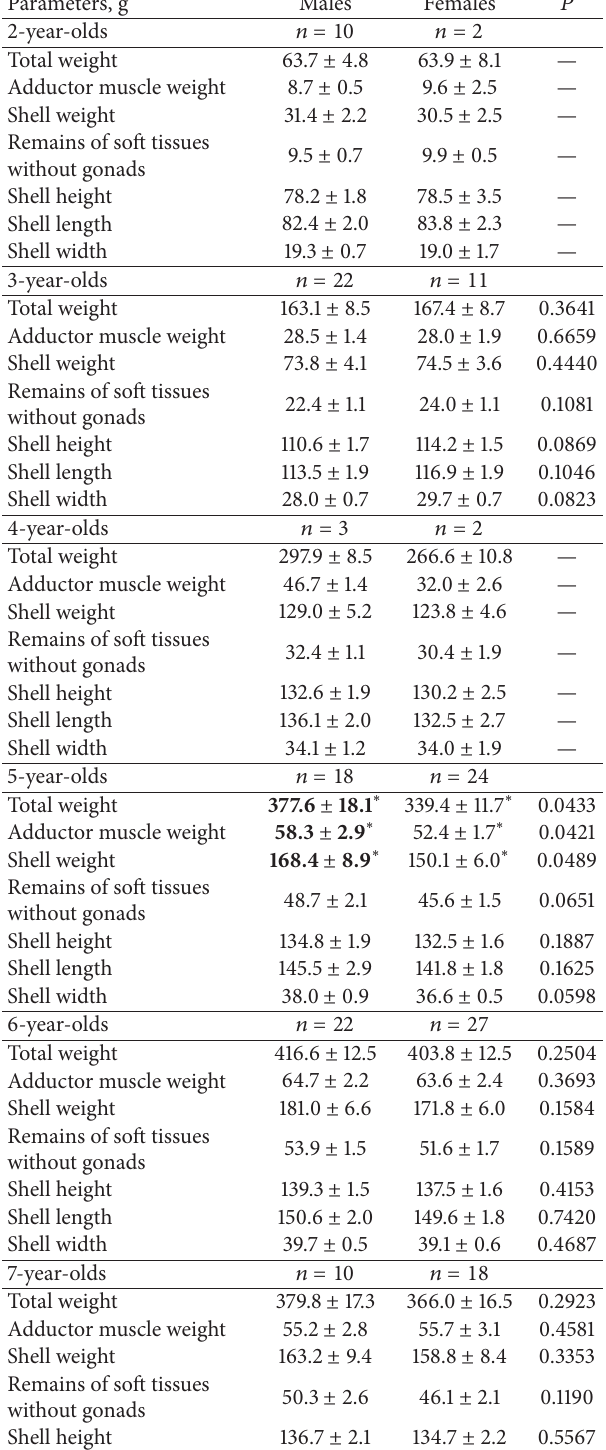
Table 2: Patinopecten yessoensis . Wet weight and size parameters of the same aged males and females from the population inhabiting Ozero Vtoroe Bay. ∗ indicates significant differences between parameters at a level 𝑃 < 0.05 ( 𝑡 -test). — indicates that data were not compared. Bold marks higher values. 𝑛 is sample size.